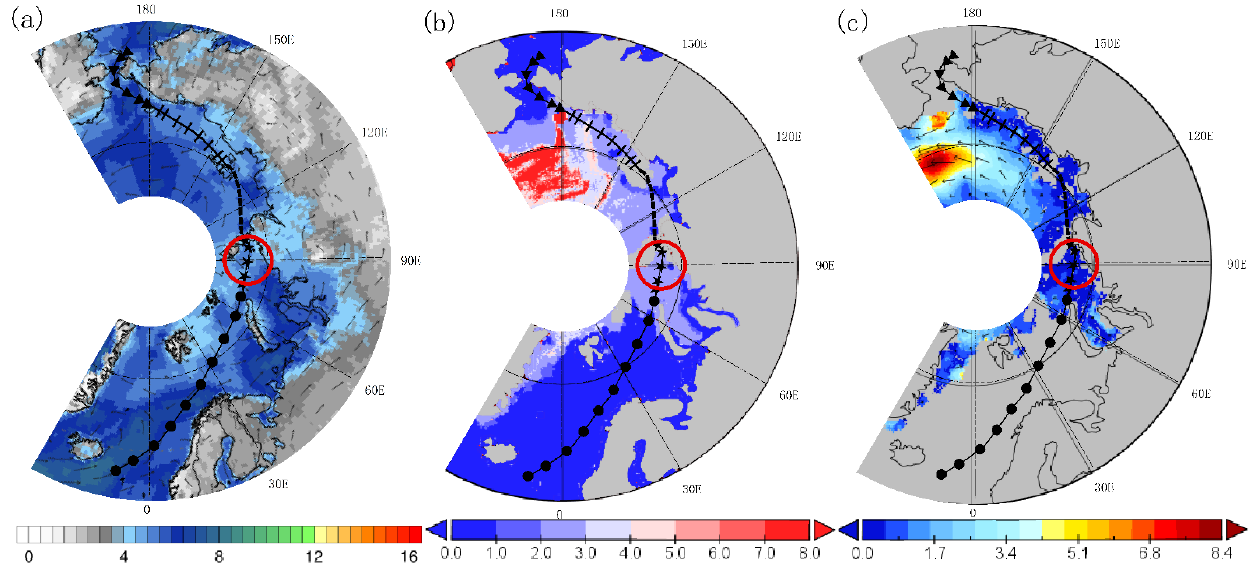
Figure 11. The average wind field ( a ), sea ice age ( b ) and sea ice movement ( c ) of the NEP in the Arctic in July 2002. J. Mar. Sci. Eng. 2021 , 9 , x FOR PEER REVIEW